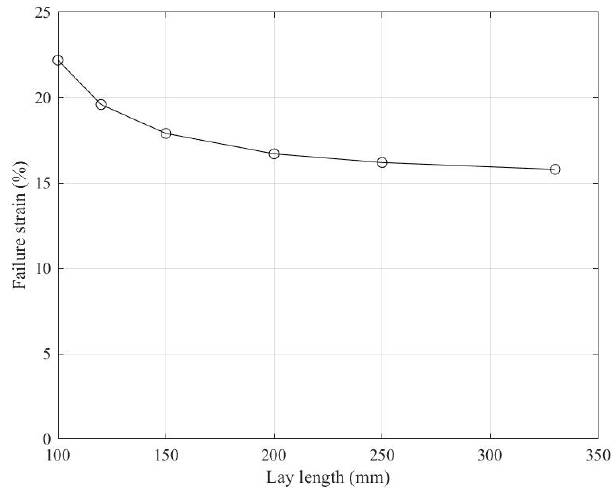
Figure 17. Influence of lay length on hybrid rope strain to failure.